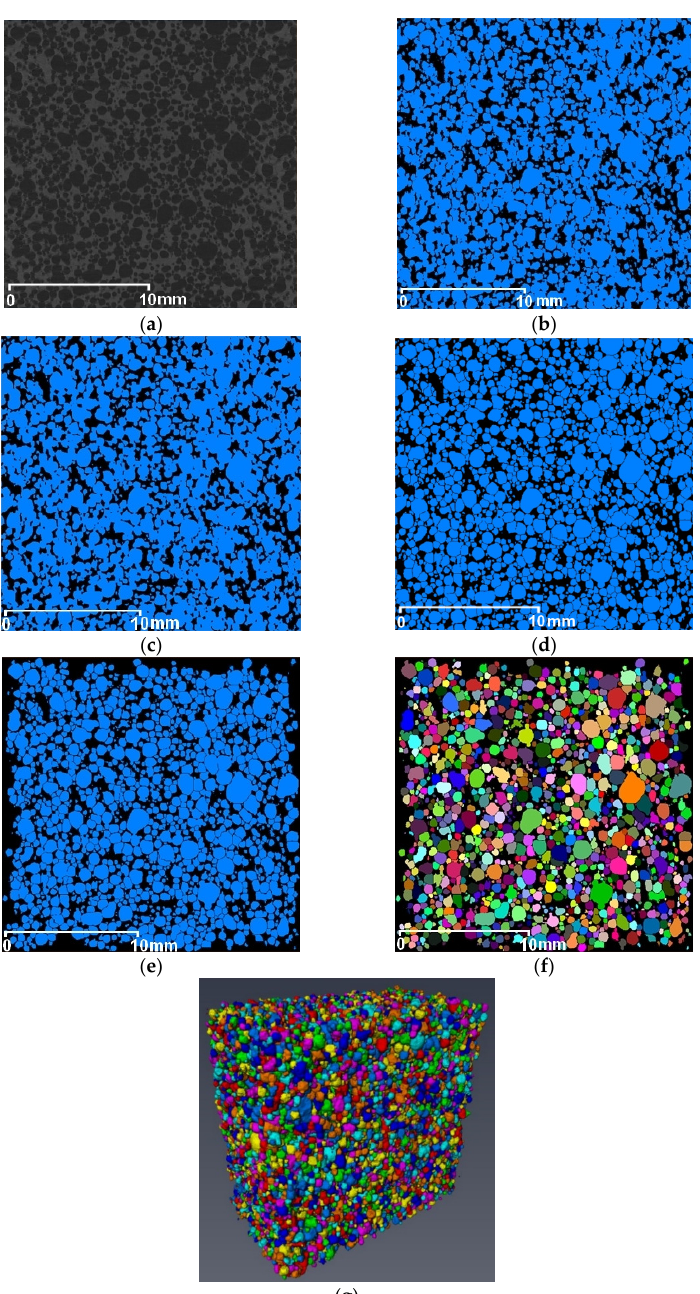
Figure 6. Microtomographic data analysis presented for one of the layers: ( a ) median filter; ( b ) binarization; ( c ) morphological opening; ( d ) disconnection of interconnected pores; ( e ) deletion of pores cut with the image frame; ( f ) result of the analysis; ( g ) result of the analysis—3D view.